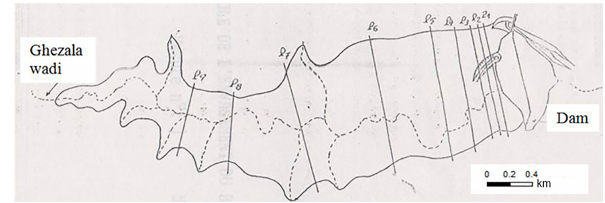
Figure 2. Location of the sediment profiles surveyed in the Ghézala dam.